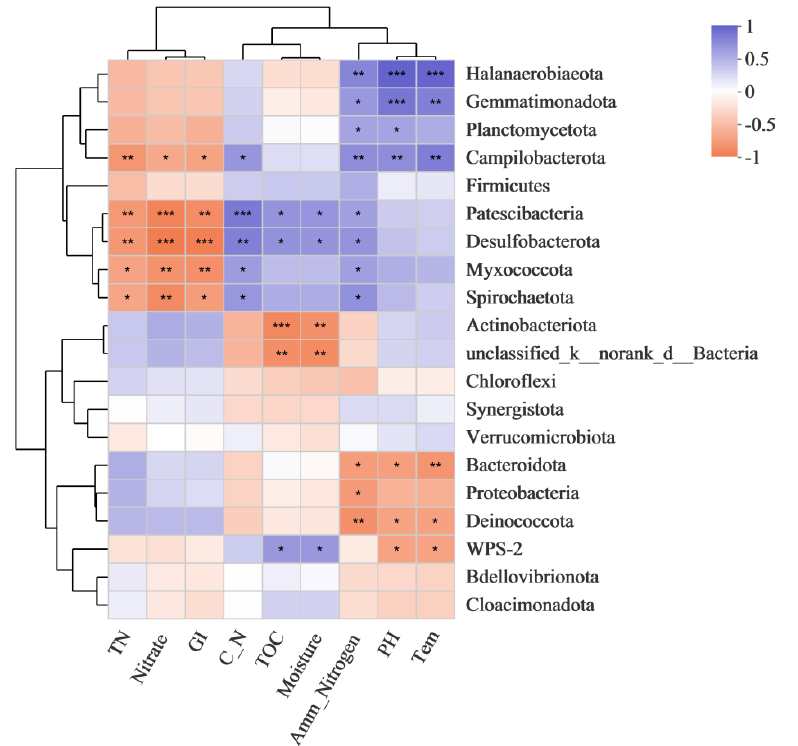
Figure 4. Spearman correlation between dominant genera and physicochemical factors during compost process. The correlation coefficient is represented by the color and size of the circles. Dark red indicates positive correlation and dark blue indicates negative correlation. p values were calculated using Spearman’s rank correlation test, * p < 0.05; ** p < 0.01; *** p < 0.001.